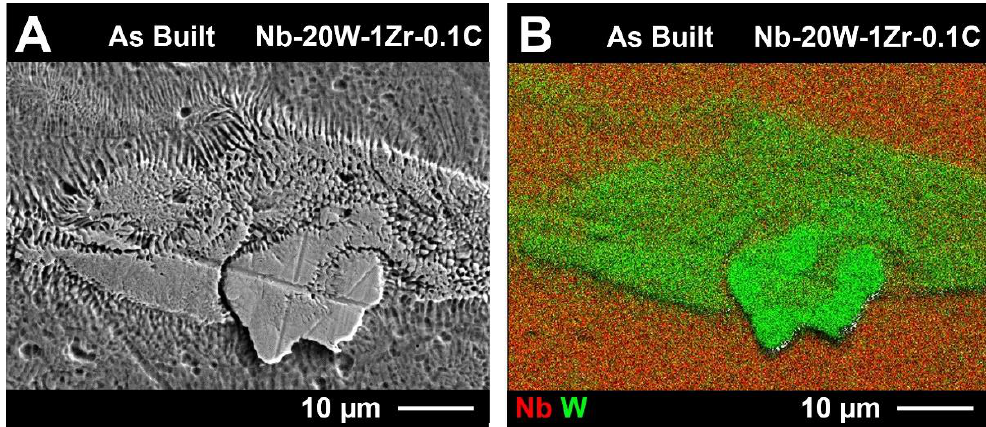
Figure 10. As-built Nb-20W-1Zr-0.1C ( A ) secondary SEM image and ( B ) EDS RGB composite image showing a graded composition and dendritic structure on the periphery of a tungsten particle.